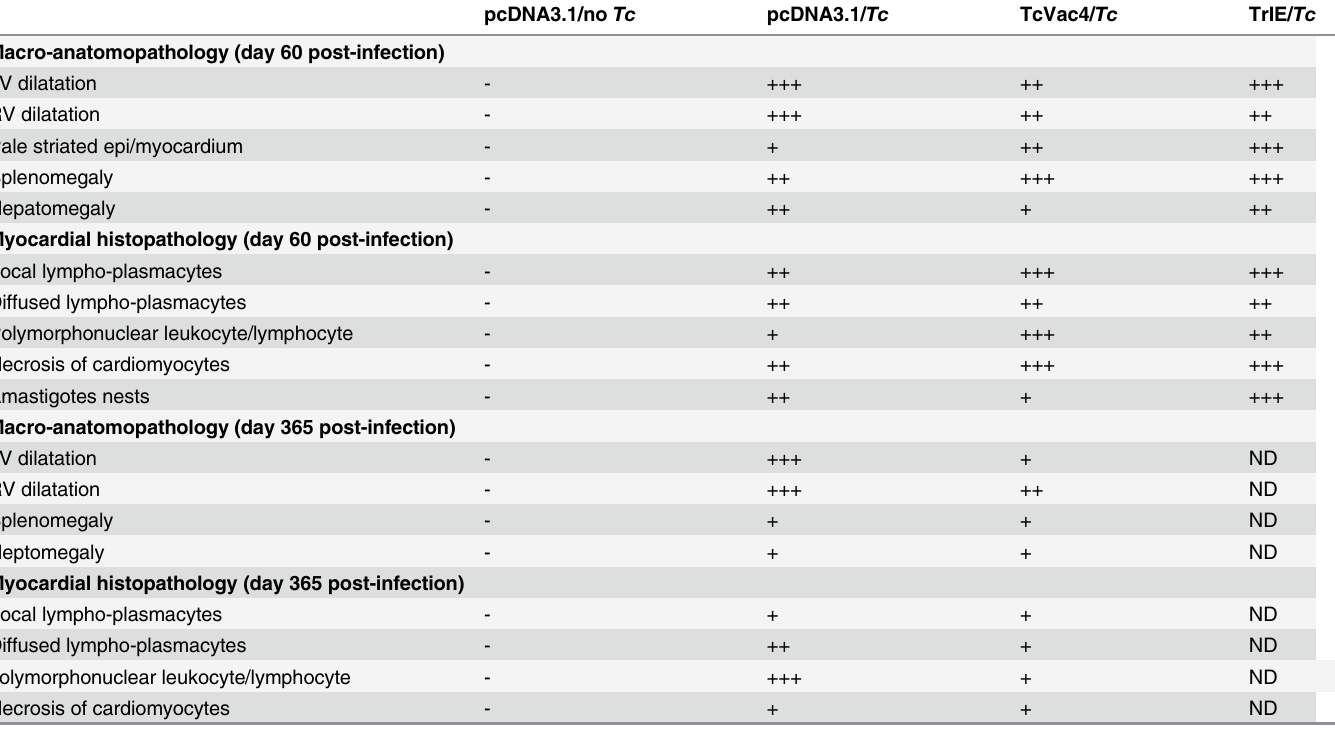
Anatomopathological and histopathological evaluations were conducted during acute (day 60 pi) and chronic (day 365 pi) phases of infection and disease development. Classi fi cation of abnormalities was conducted according to [25] and [39], and represented as-, None; +, slight; ++, moderate; and +++, severe; ND, Not determined (animals not included for the study of these